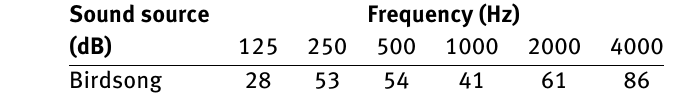
Table 3: Octave band spectrum (dB) of the birdsong sound source used for simulation